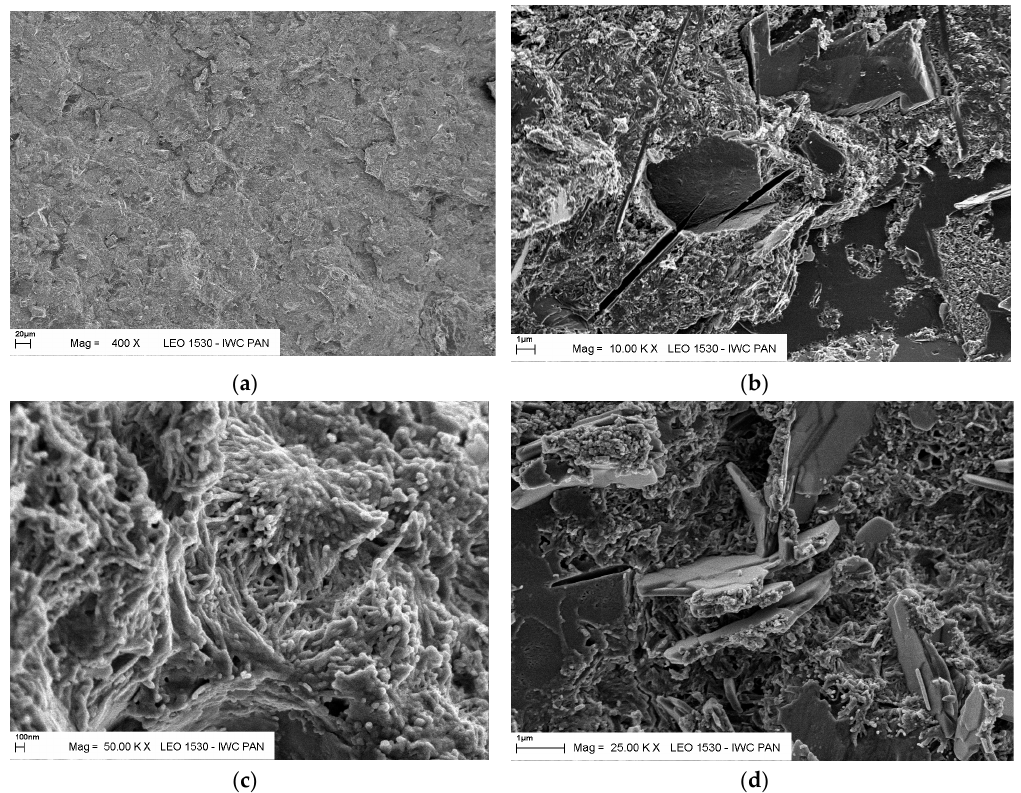
Figure 6. Microphotographs of hardened cement paste with CFBC fly ash (K30), matured in water for 400 days. ( a ) Cement paste; ( b ) C–S–H and relics of clinker, microcracks; ( c ) carbonated hydration products; ( d ) C–S–H and relics of clinker.